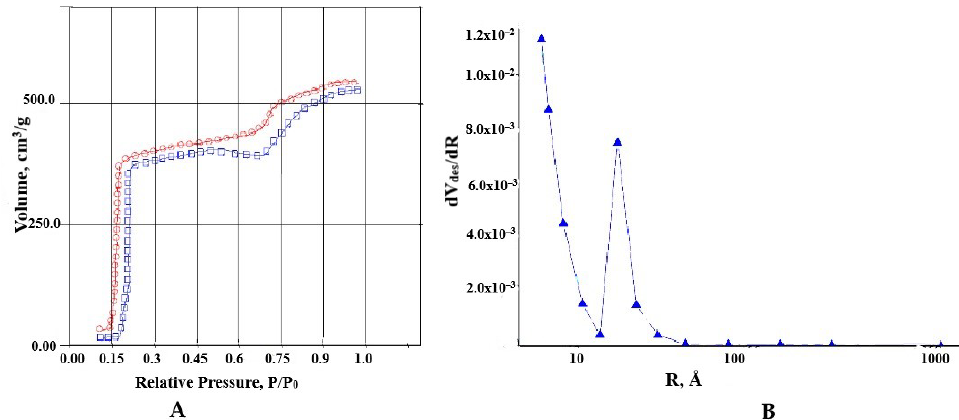
Figure 3. N 2 adsorption–desorption isotherms ( A ) and the pore size distribution curve ( B ) for MOF.